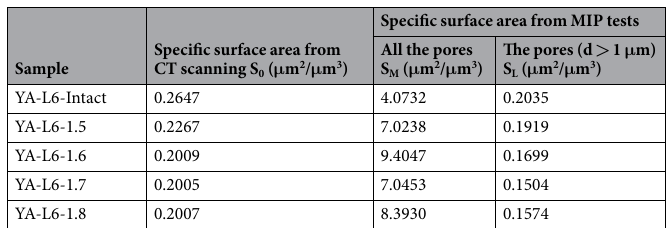
Table 2. Specific surface area for different samples from different tests. S divided by the volume of the soil skeleton from CT scanning. S by the particle skeleton volume of the large size sample from MIP test. S μ m) divided by the particle skeleton volume of the large size sample from MIP test.